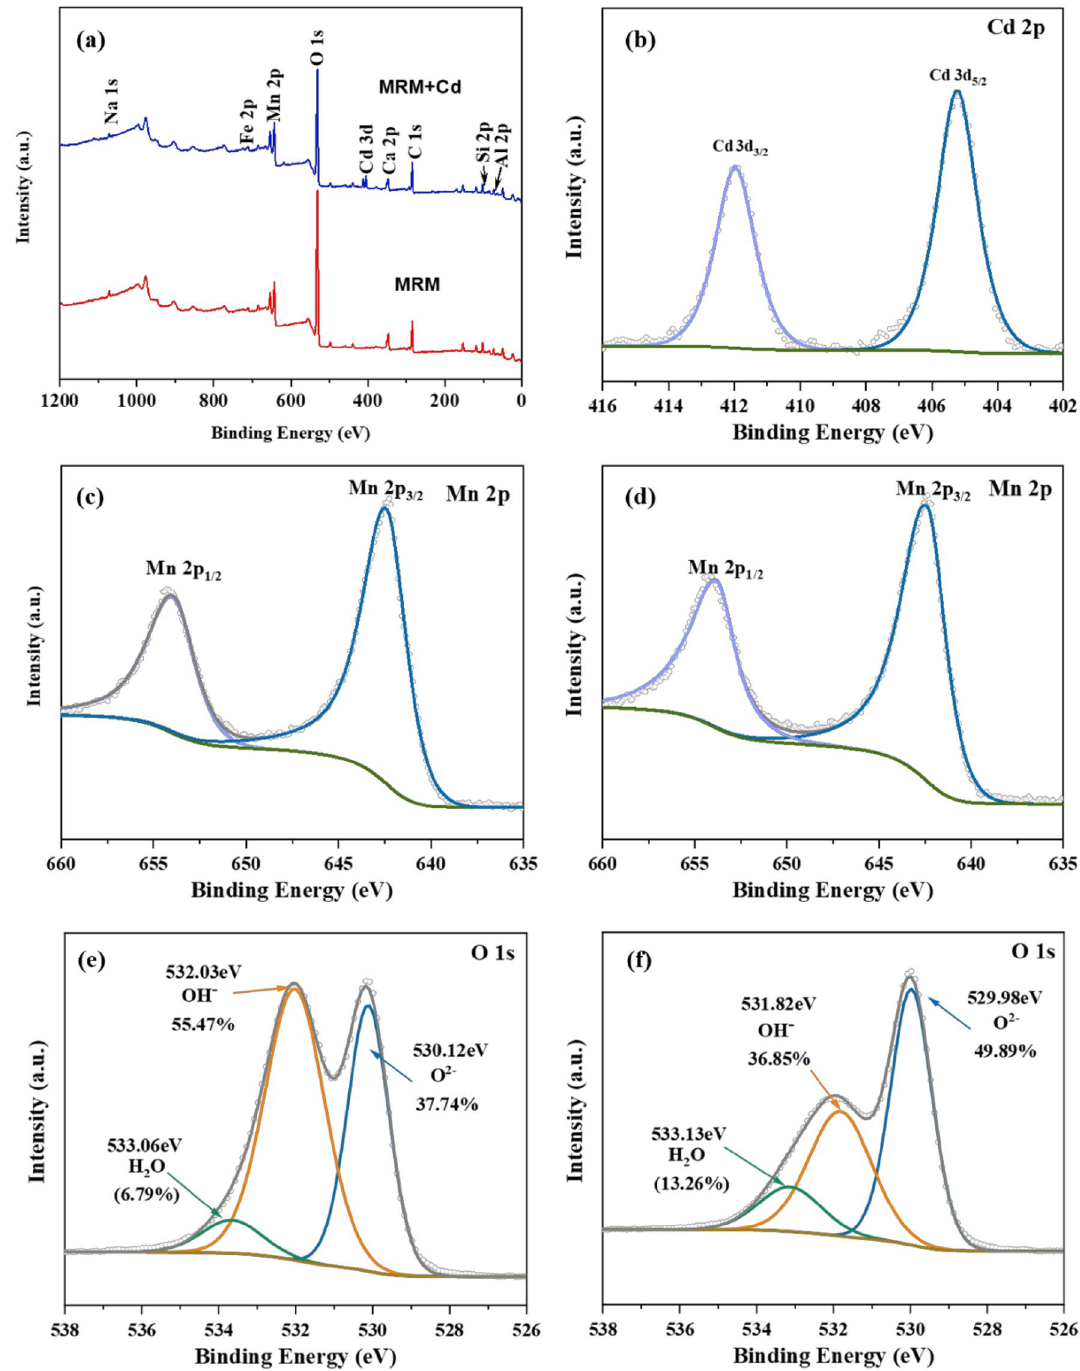
Figure 17. XPS results of MRM before and after adsorption (full spectra ( a ) and after the adsorption of Cd 3d ( b ), Mn 2p spectra ( c ) before and after adsorption, O 1s spectra before adsorption ( d ) and after the adsorption of Cd 2+ ( e